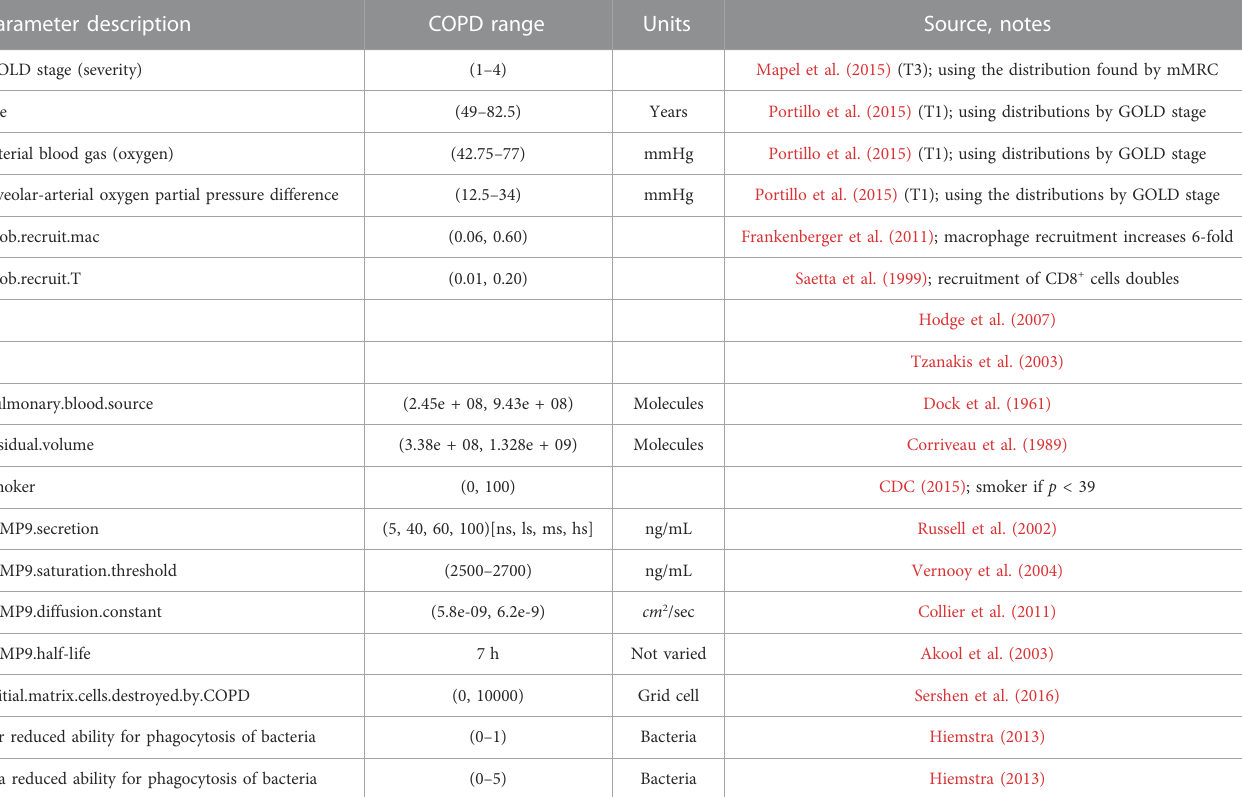
TABLE 1 COPD associated parameters for the ABM-PHYS. Ranges correspond to upper and lower bounds used in the Latin hypercube sampling (LHS) based sensitivity analysis to identify model